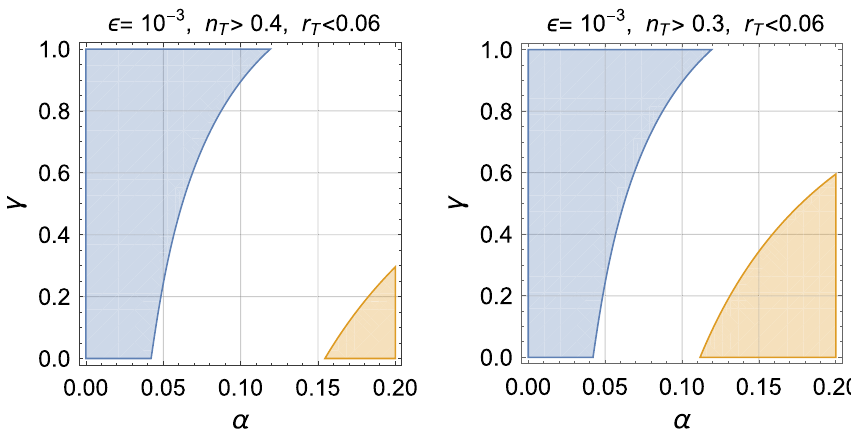
Fig. 4 The constraints on r T and n T are translated in the (α, γ) plane for the values of n T compatible with an observable signal in the audio band (i.e. Hz ≤ ν ≤ 10 4 Hz) and in the generic case of an instrument able to probe spectral energy densities O ( 10 − 10